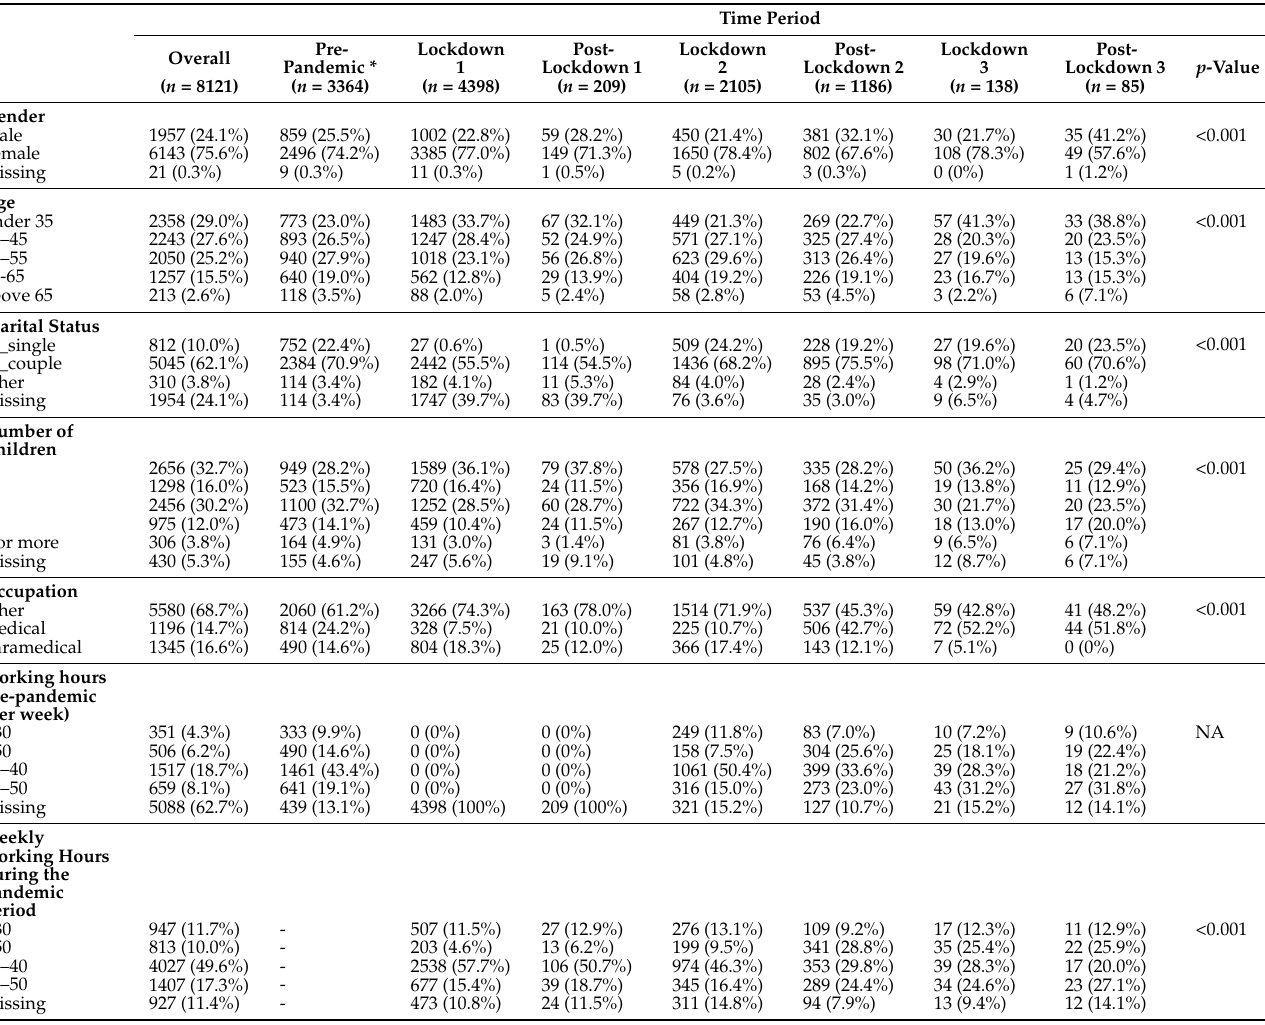
Table 1. Participants’ characteristics, in the whole cohort and by periods of interest. *: The Pre- pandemic column aggregates the records in which the ERI at the pre-pandemic period was available. The weekly workload during the pandemic periods is thus absent from this pre-pandemic